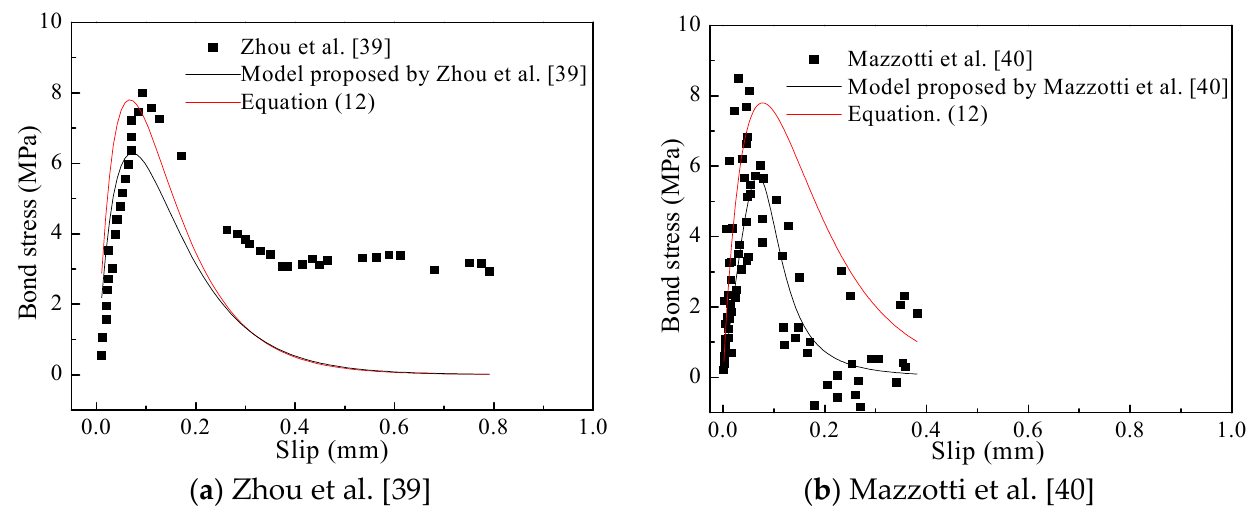
Figure 11. Verification of the proposed model: (a) Zhou et.al [39]; (b) Mazzotti et.al [40].